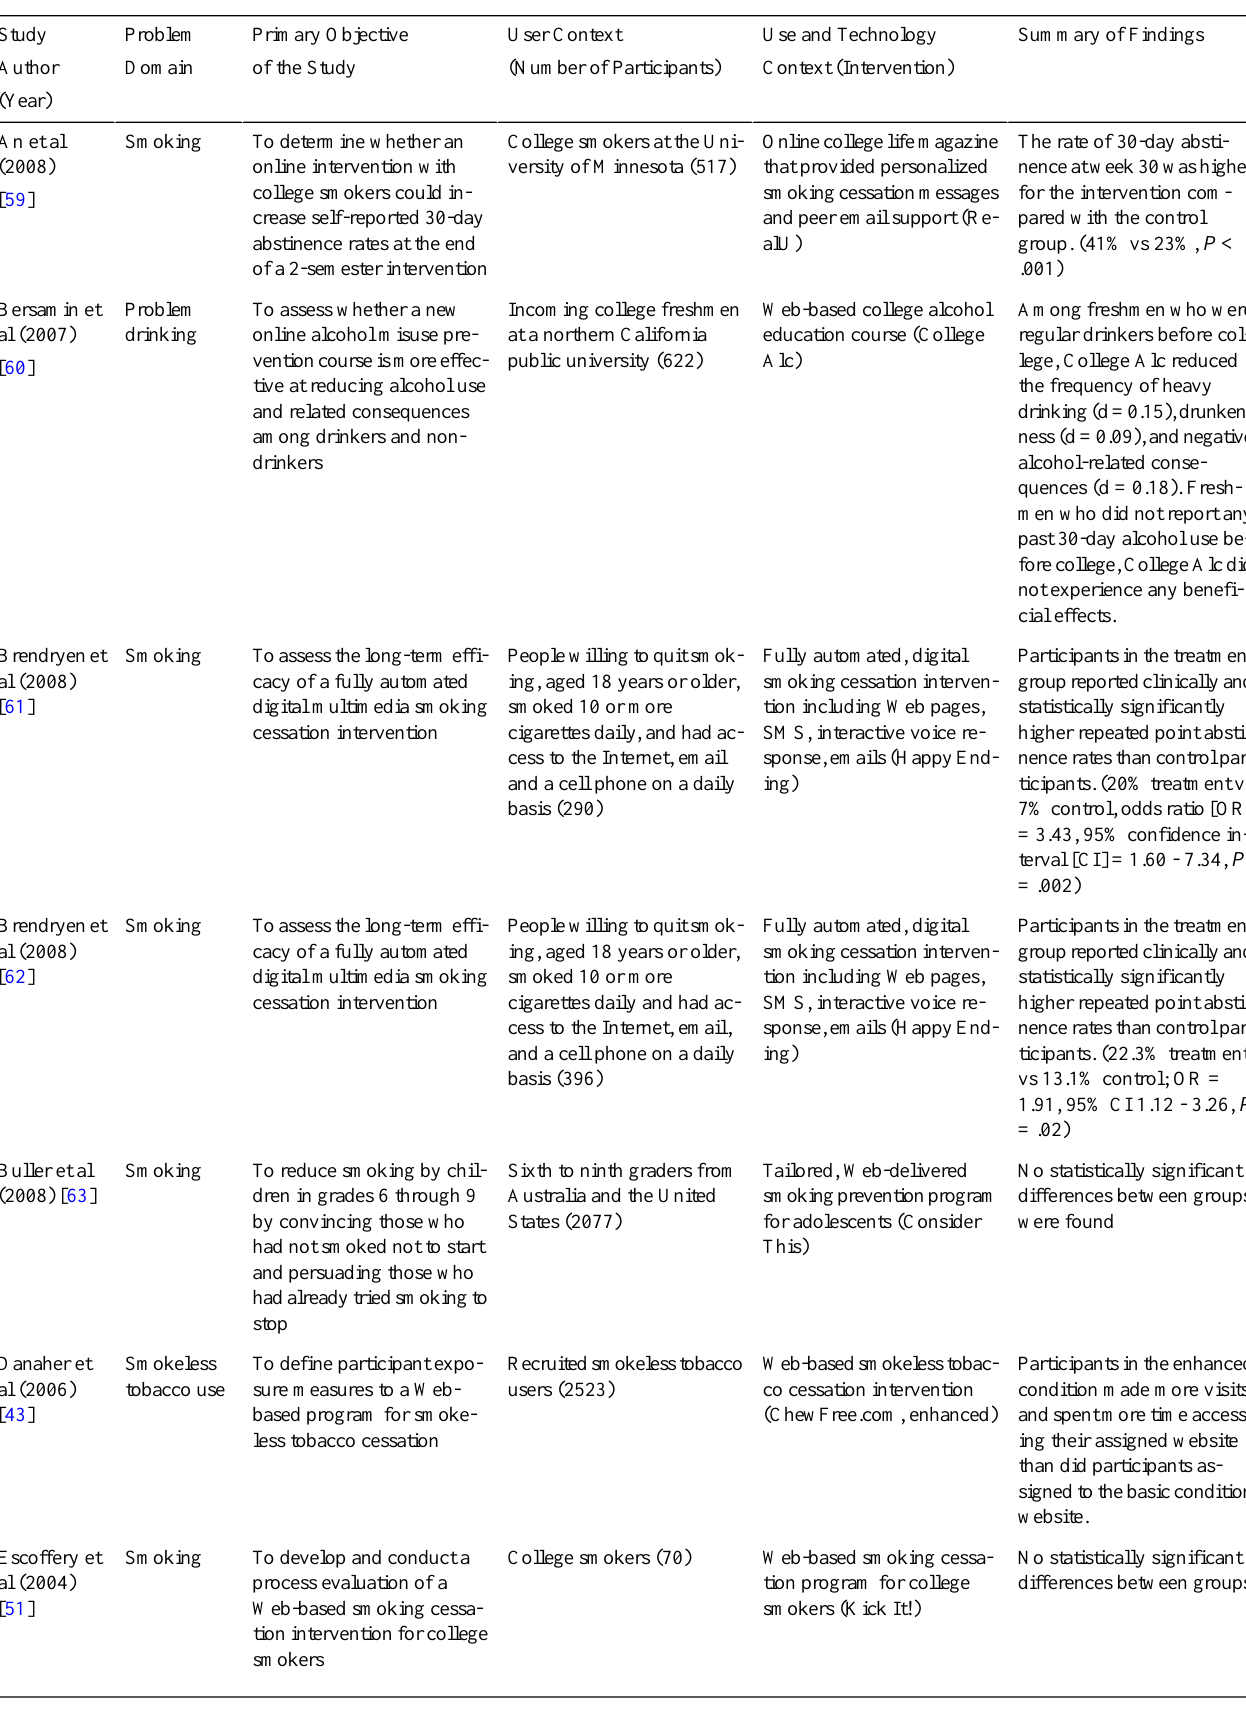
Table 1. Characteristics of the included studies